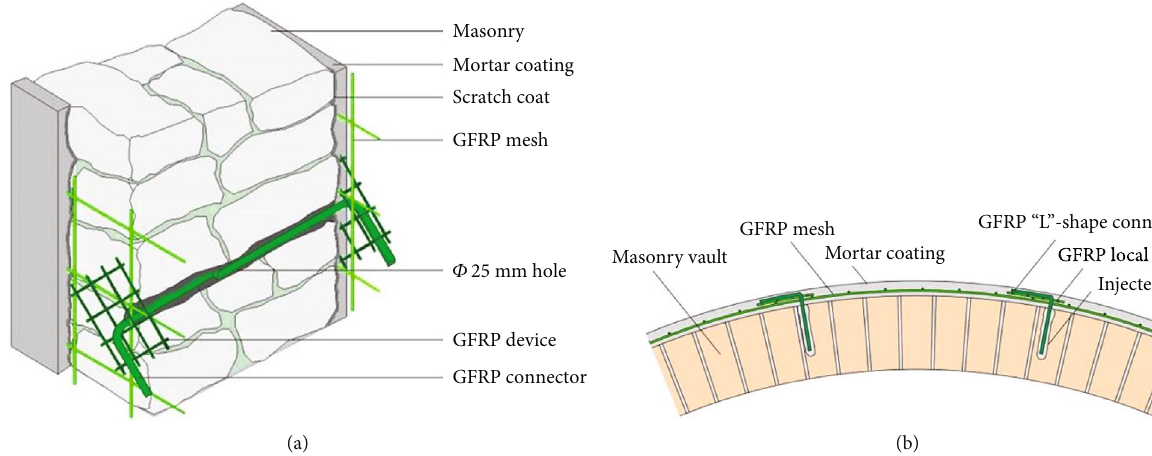
Figure 3: Schematic of the GFRP mortar coating system used (a) on two sides of a masonry wall or (b) at a vault extrados